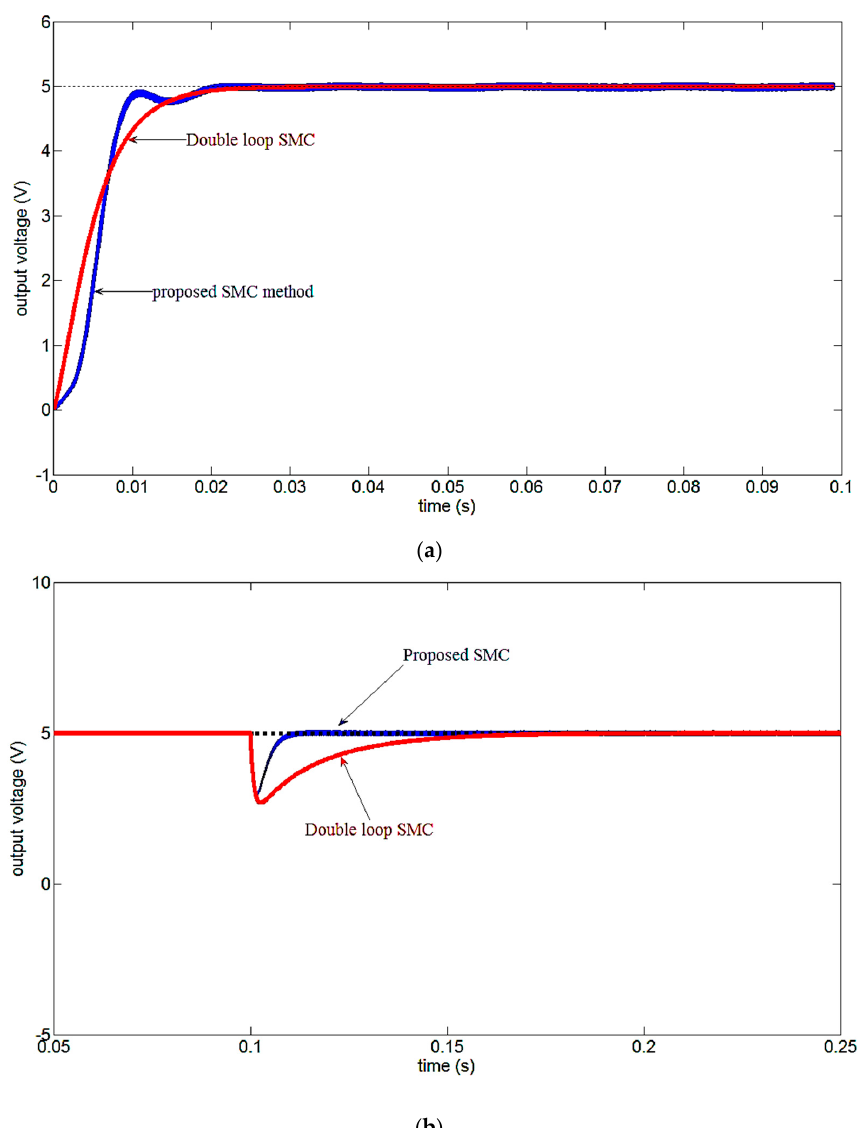
Figure 5. Response of the presented adaptive PSMC in comparison with the standard double-loop SMC2. ( a ) Comparison of the proposed PSMC and double − loop SMC [18] at system start-up. ( b ) Comparison of the proposed adaptive PSMC and double − loop SMC during the converter load changes in continuous operation.